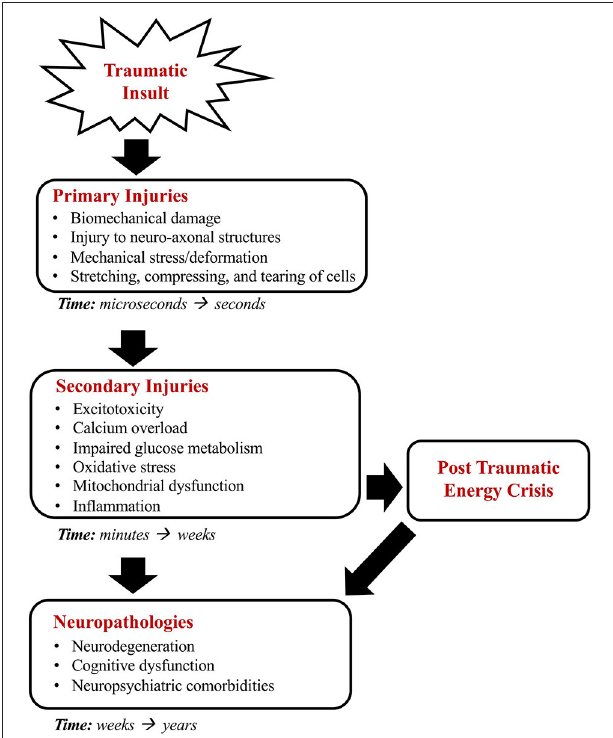
FIGURE 1 | A schematic representation of injury processes following a TBI. The mechanical forces of the traumatic insult result in primary injuries characterized by deformations in brain tissue. Following the primary injury, secondary injuries ultimately result in cerebral energy deficiencies and long-term